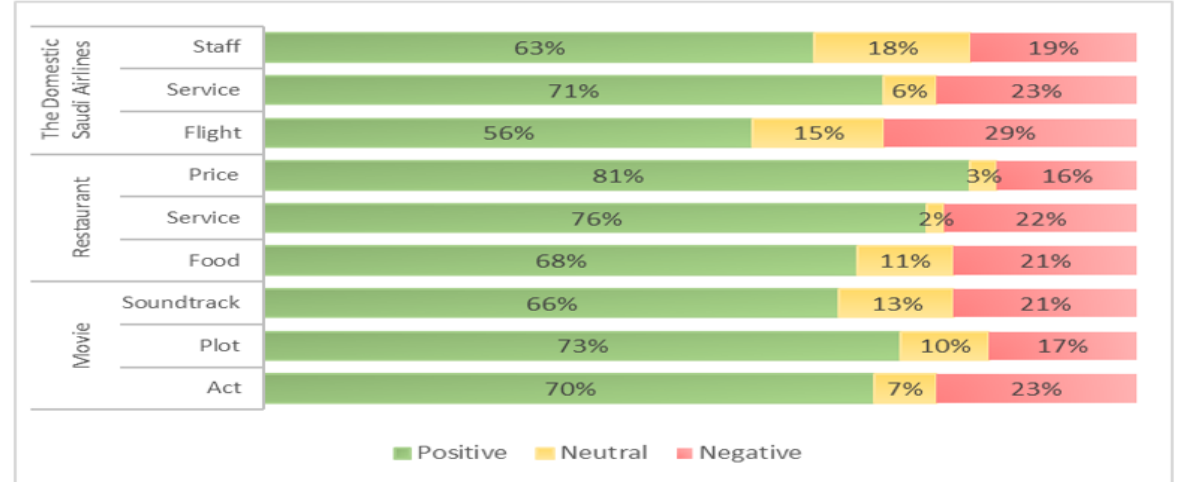
Figure 4. Distribution of sentiment polarity.